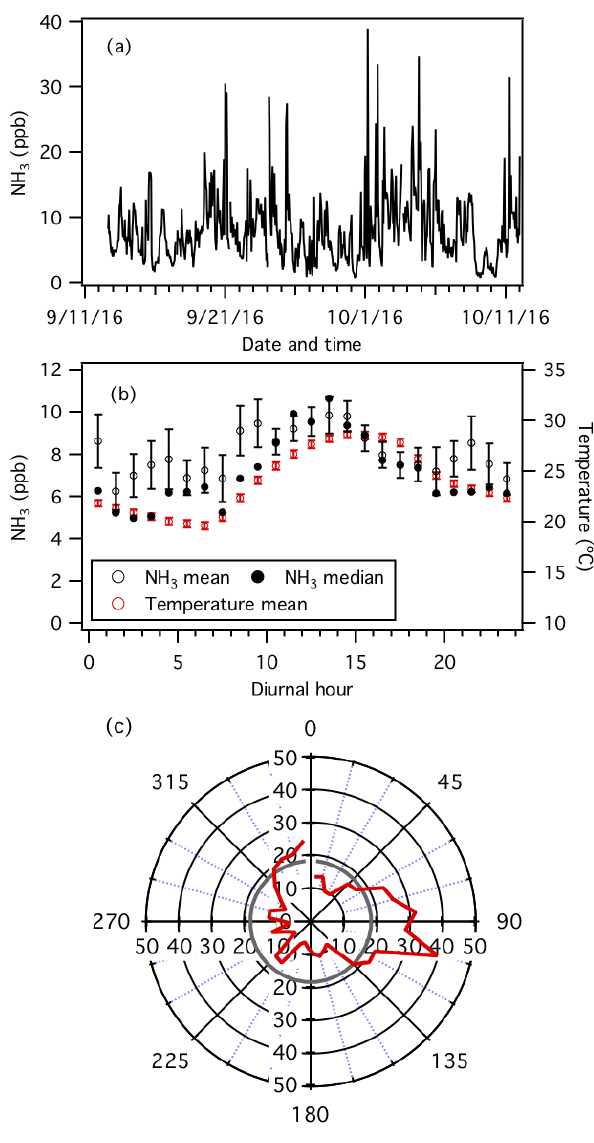
Figure 1. Measurements by the NH 3 -CIMS during the second half of the study. (a) Time series of NH 3 concentration. The data are displayed as 1h averages. (b) Diurnal profiles of NH 3 concentra- tion (mean and median) and temperature. Error bars shown are the standard errors. Dates and times displayed are local time. All the concentrations represent averages in 1h intervals and the standard errors are plotted as error bars. (c) Average NH 3 concentration nor- malized to wind speed (i.e., NH 3 concentration (ppb) × wind speed (ms − 1 )) in each 10 ◦ bin (red line). The average normalized NH 3 concentration is shown as a grey